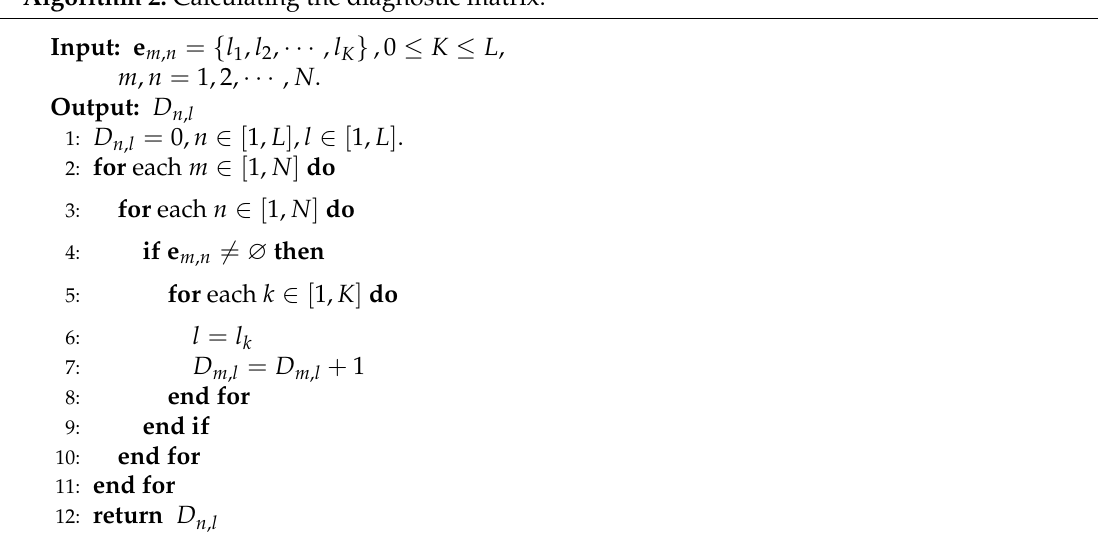
Algorithm 2: Calculating the diagnostic